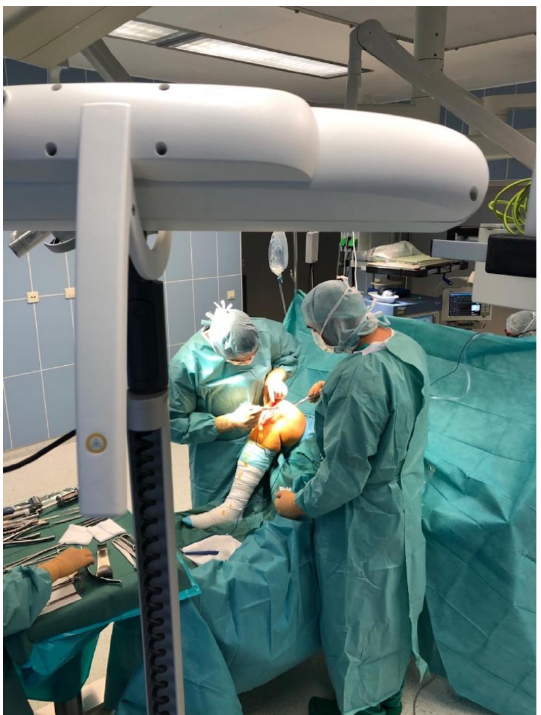
Figure 3. Shows the infrared camera facing the surgical field for detecting the light-reflecting spheres of the